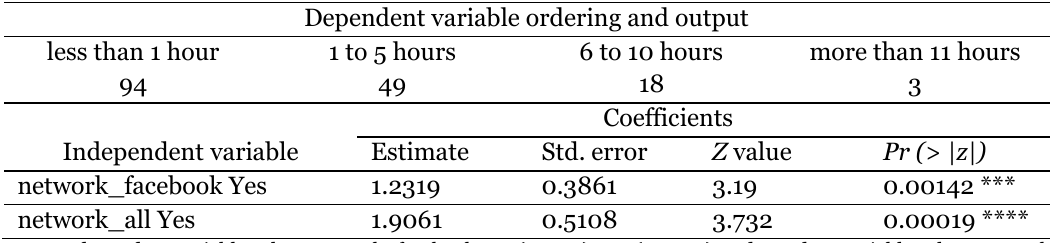
Significance of Interaction Time, With Social Media as Independent